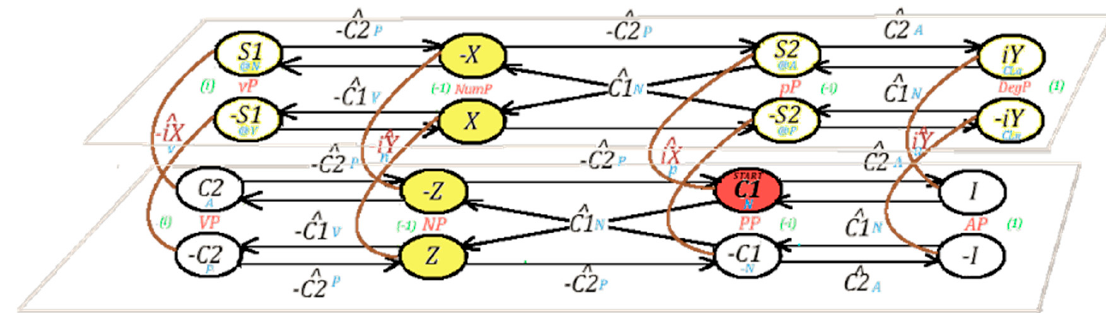
Figure 2. A (tentative) version of the SJG.